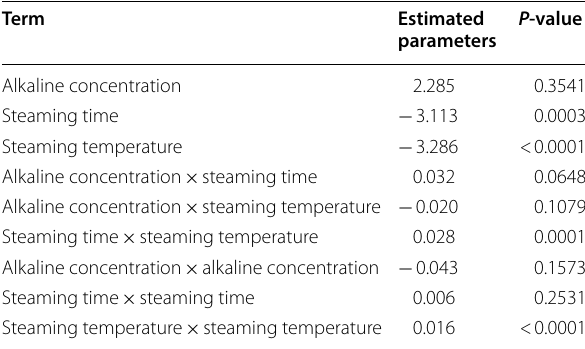
Table 3 Estimated regression coefficients for